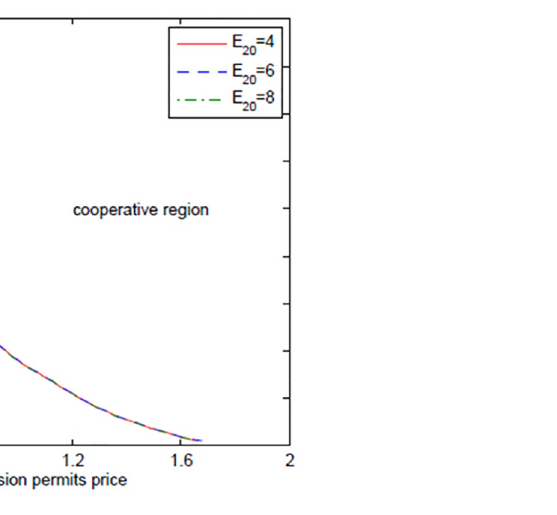
Fig 19. The effects of E 20 on the optimal decision